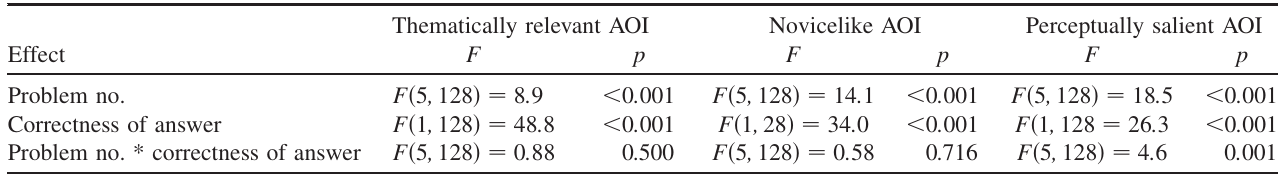
TABLE III. Results of mixed factorial ANOVA for all three AOI types for full problem period. * indicates an interaction of the effects of problem number and correctness of answer.